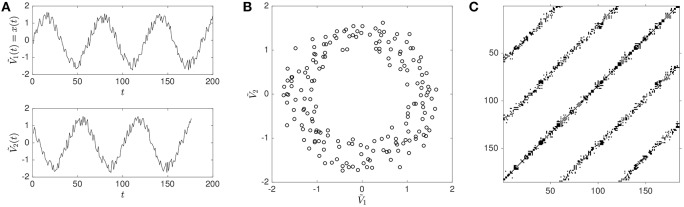
Illustration of phase-space reconstruction and resulting RP using a noisy sine-wave. A noisy sine-wave in the upper panel of (A) and its time-shifted copy (surrogate) in the lower panel of (A). Reconstructed phase-space portrait (B), obtained by plotting the original sine-wave V~1 against its time-delayed copy V~2. Resulting RP (C), where diagonal lines of recurrences (black dots on the plot) indicate that the sine-wave signal repeats itself at intervals of roughly 60 data points. The speckled appearance of the diagonal lines indicates that repetitions are not perfect (i.e., the presence of noise).